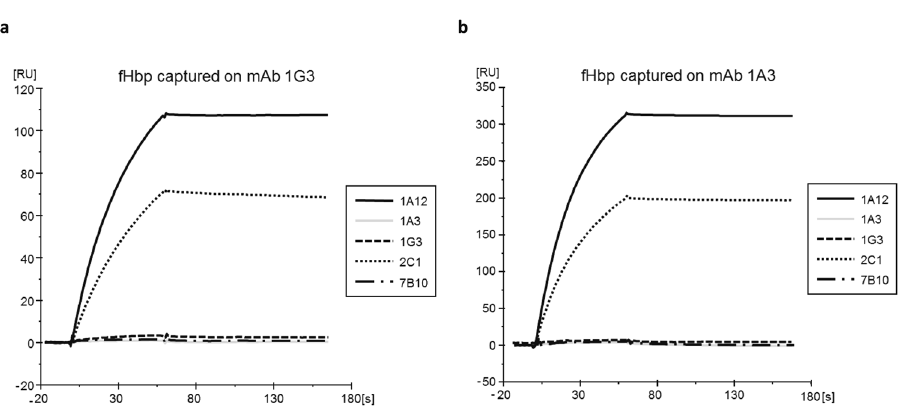
Figure 2. SPR Sensorgrams of various mAbs with fHbp:mAb complexes. 100 RU of fHbp were captured on immobilized mAbs 1G3 (panel a) or 1A3 (panel b). After a stabilization period, various mAbs (100 nM) were injected for 60 s and the dissociation of eventually formed ternary complexes was followed for another 120 s. The fHbp capturing phase is omitted; sensorgrams were aligned at the start of injection of the second mAb (baseline = 0